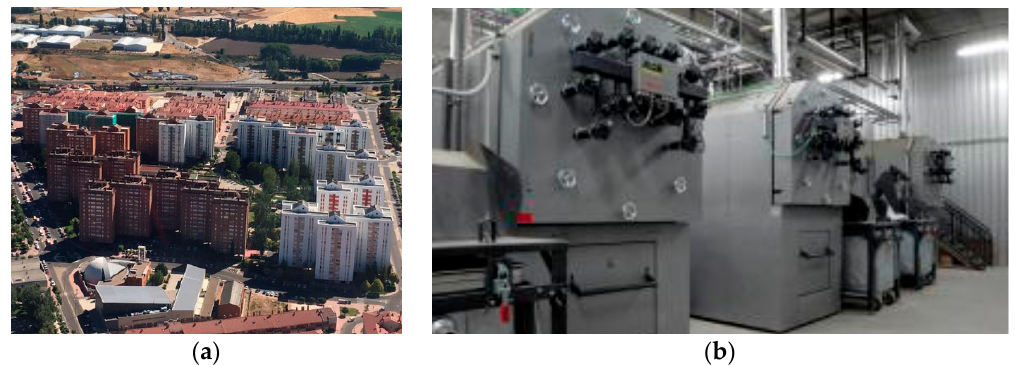
Figure 1. ( a ) Current status of the district, ( b ) Biomass thermal plant.